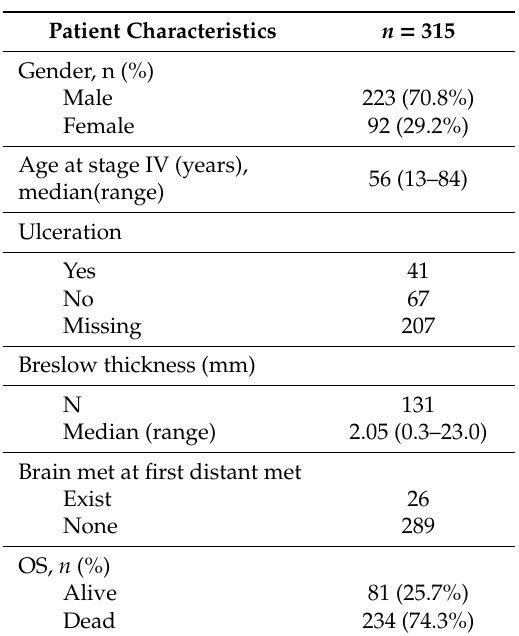
Table 1. Patient demographics and survival status.